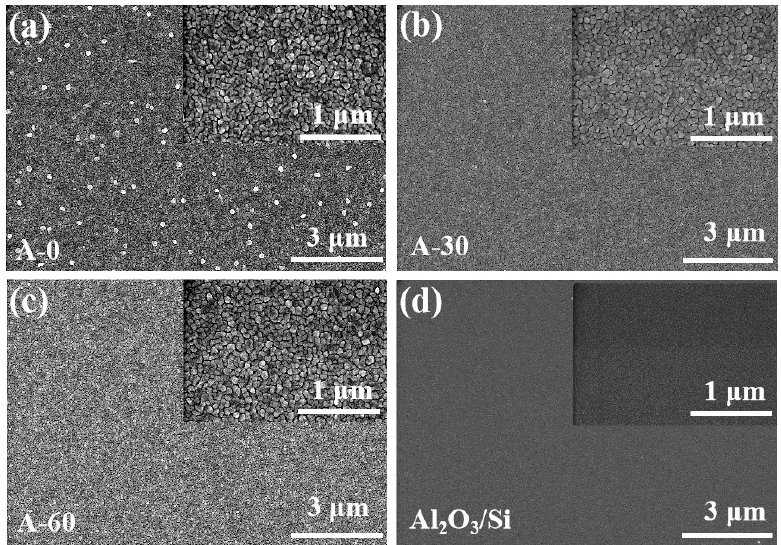
Figure 2. SEM images of A-series samples with different annealing-time. ( a ) The sample in prepa- ration state (A-0). ( b ) The sample with 30 min post-annealing (A-30). ( c ) The sample with 60 min post-annealing (A-60). ( d ) Al 2 O 3 /Si annealed at 750 °C for 60 min. The corresponding enlarged pic- ture is inserted in each